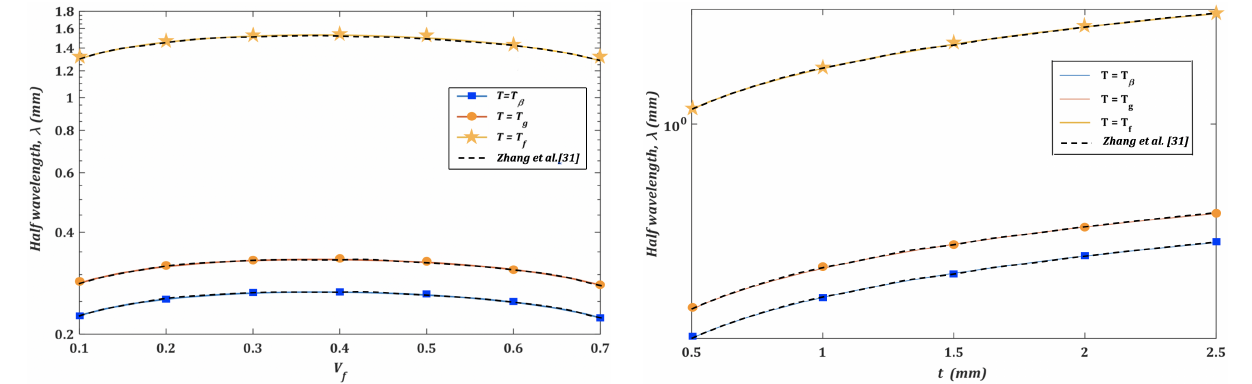
Figure 12: Variation of the half fiber buckling wavelength ( λ ) with respect to fiber volume fraction at T = T β , T g and T f